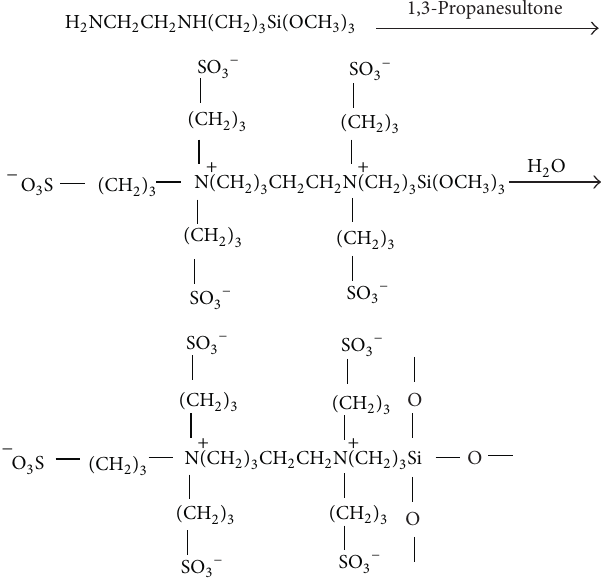
Scheme 1: The production of hybrid precursor (nonstoichiometric